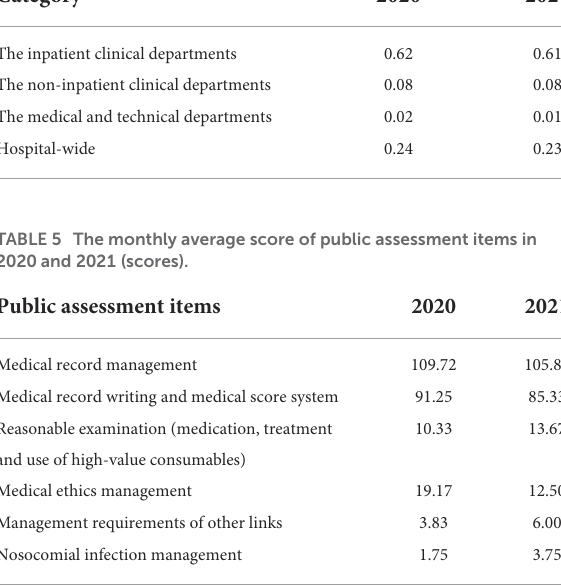
TABLE 4 The hospital scored per capital monthly in 2020 and 2021 (scores). Category